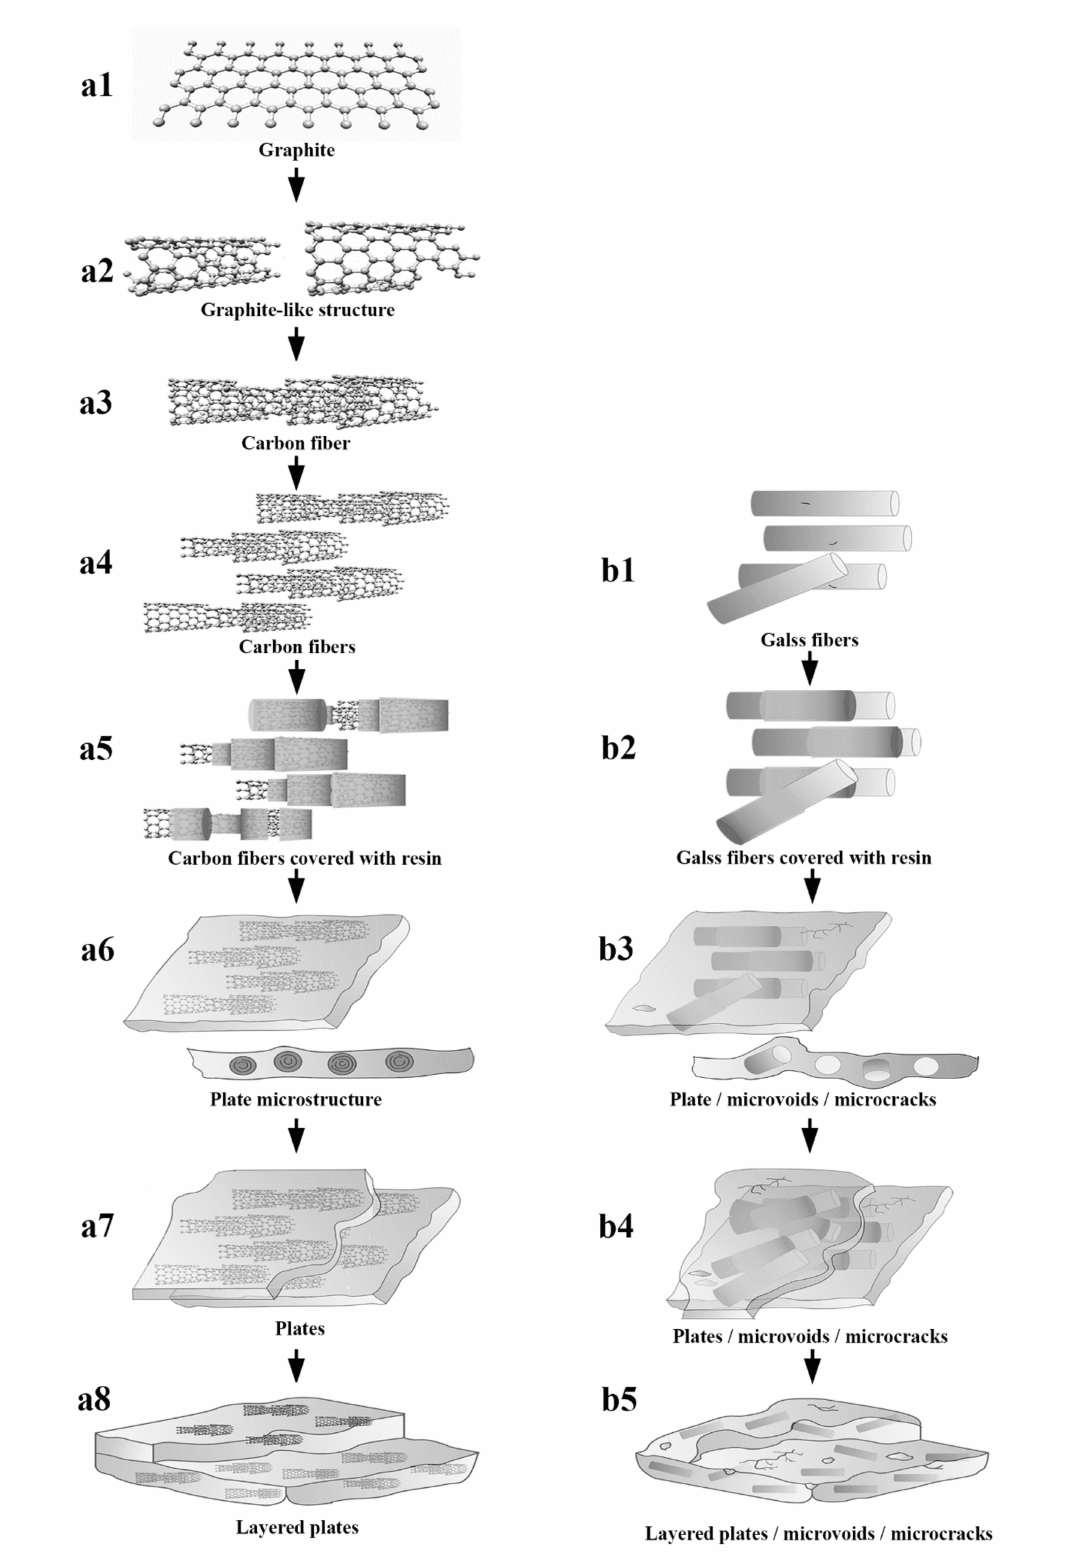
Figure 9. The formation mechanism diagrams of the matrix microstructure of CCFR-LDUPR and CGFR-LDUPR samples. The surface of chopped glass fibers was smooth but with some flaws (see Figure 9(b1)). After the soaking of UPR glue, resin glue covered the surface of chopped glass fibers illustrated in Figure